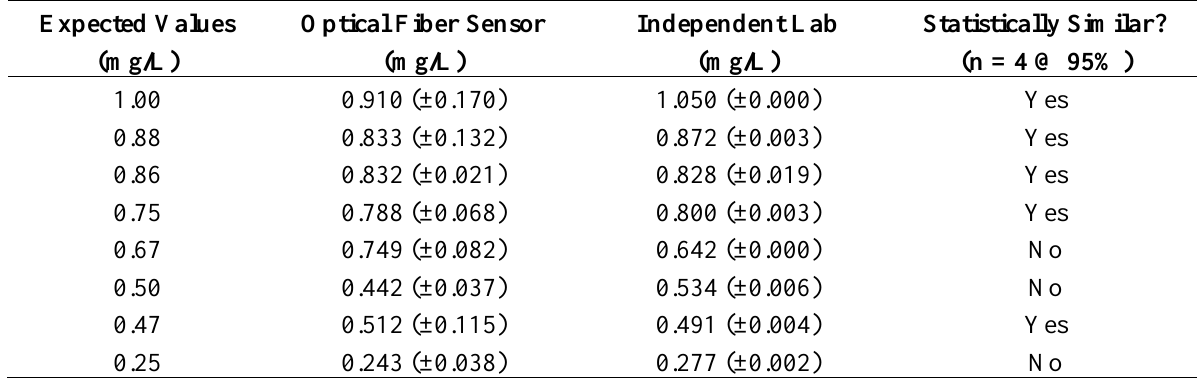
Table 1. The average concentration of zinc present in simulated samples as measured by both optical fiber sensor and an independent lab. The data in the table column labeled ―statistically similar?‖ are the result of the Student’s t-test to compare the values obtained by the optical fiber sensor against the independent